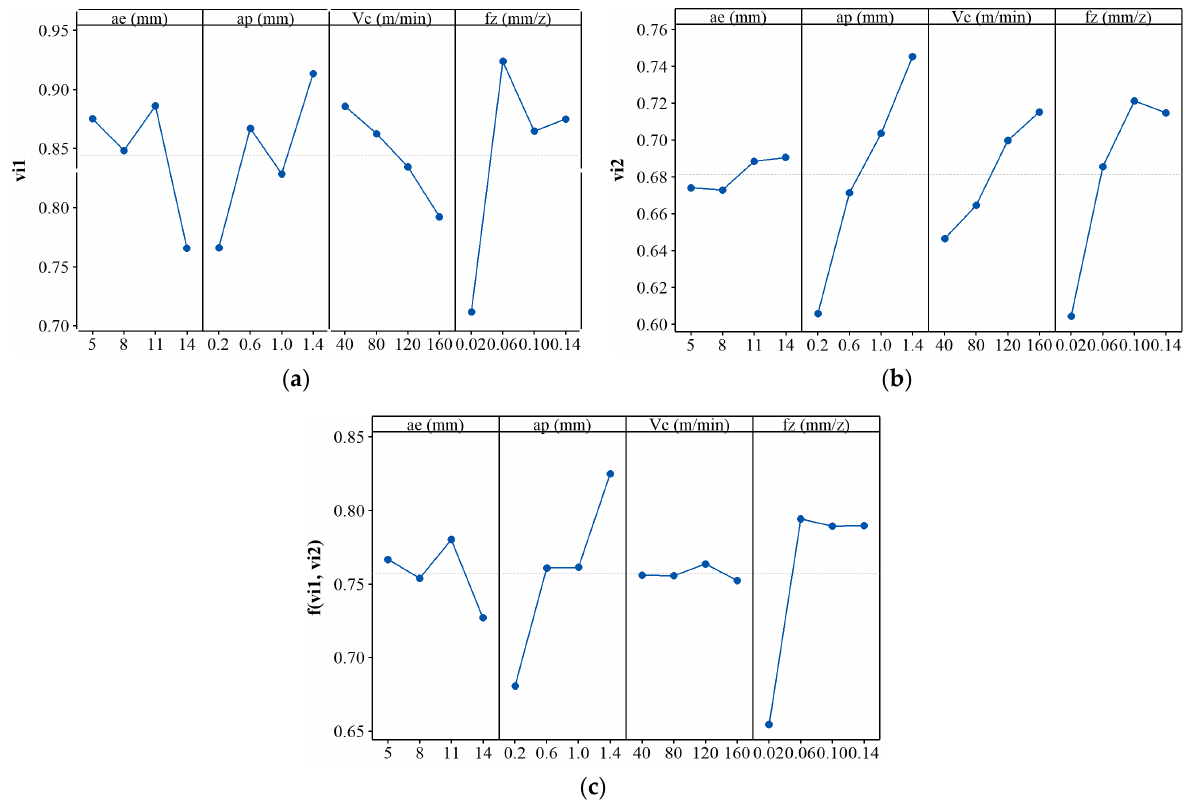
Figure 13. Plot of means for ( a ) evaluation quantity v i 1 , ( b ) v i 2 , and ( c ) machinability evaluation results f ( v i 1 , v i 2 ) in asymmetric up-milling TC25.